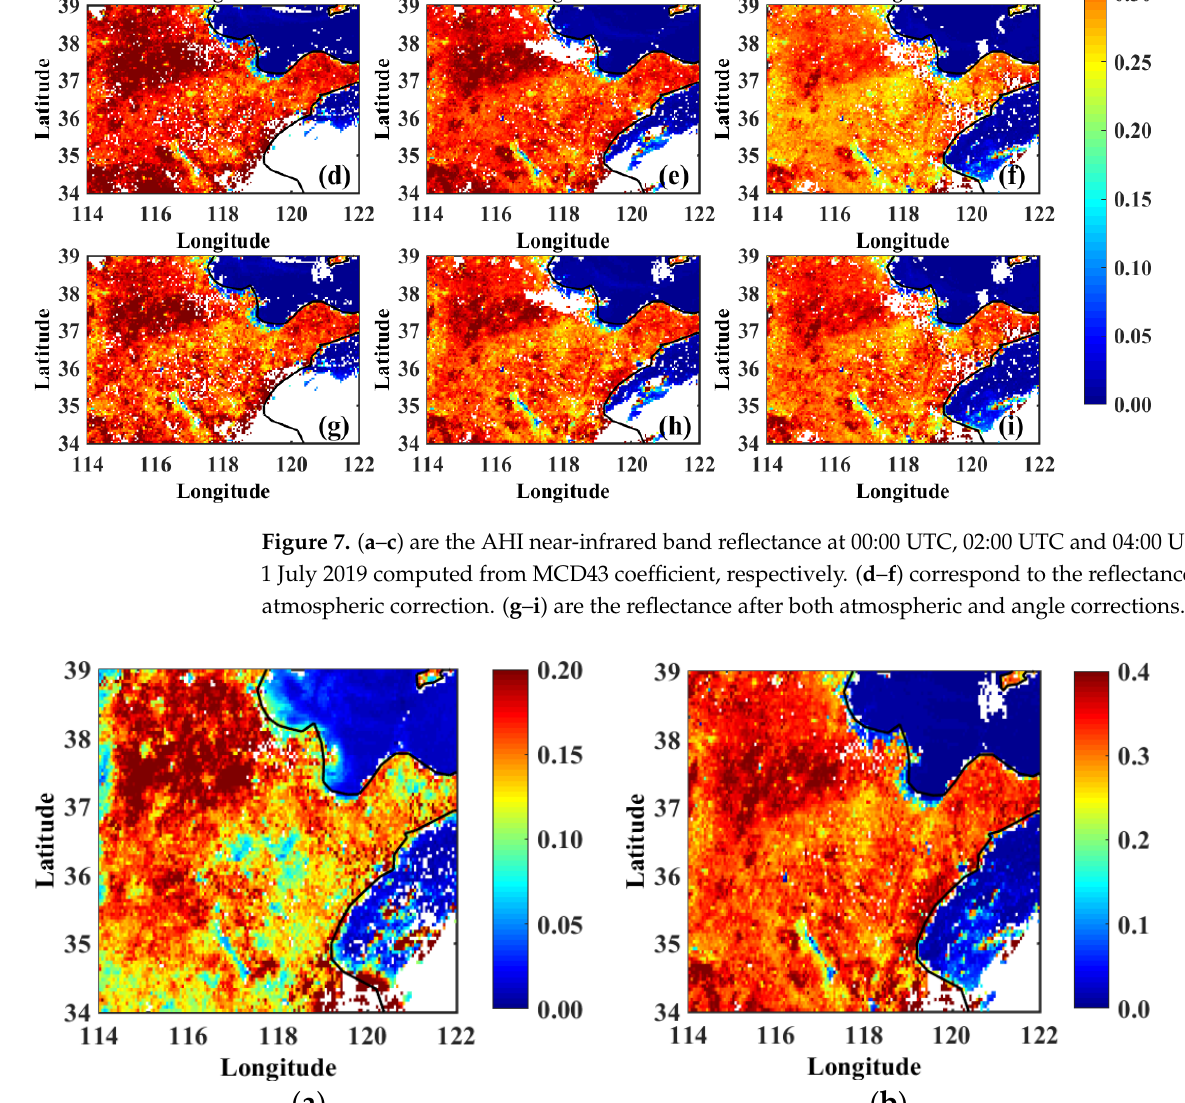
Figure 8. AHI composited reflectance at red band on 1 July 2019. ( a ) red band and ( b ) NIR.